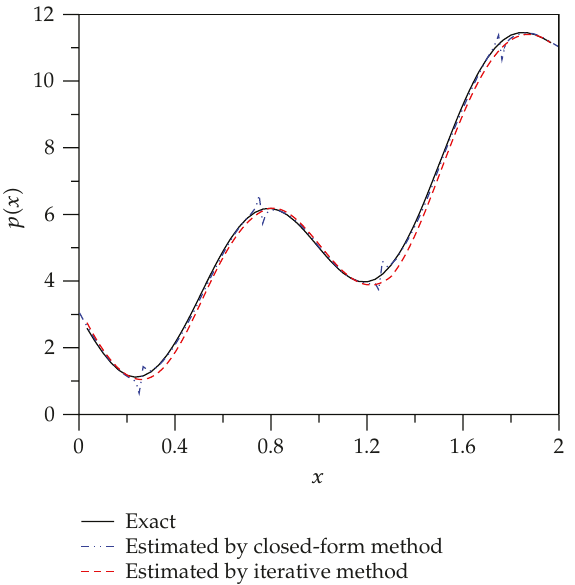
Figure 4: In Example 6.4 we compare exact p (cid:6) x (cid:7) with the estimated ones by using an iterative method and a closed-form